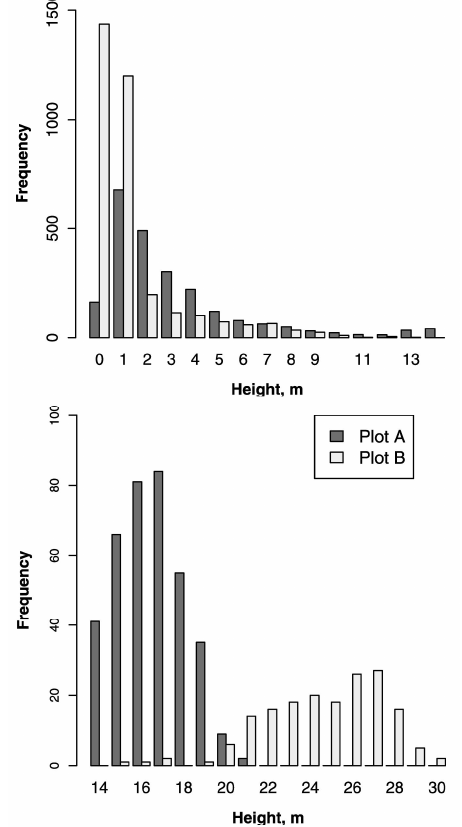
Fig. 1. h -distributions of trees in plots A and